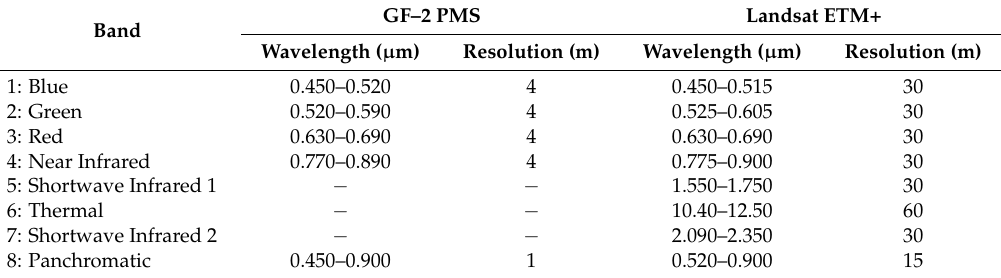
Table 1. Spectral bands of GaoFen-2 (GF-2) Panchromatic/MultiSpectral (PMS) as compared with those of Landsat ETM+.